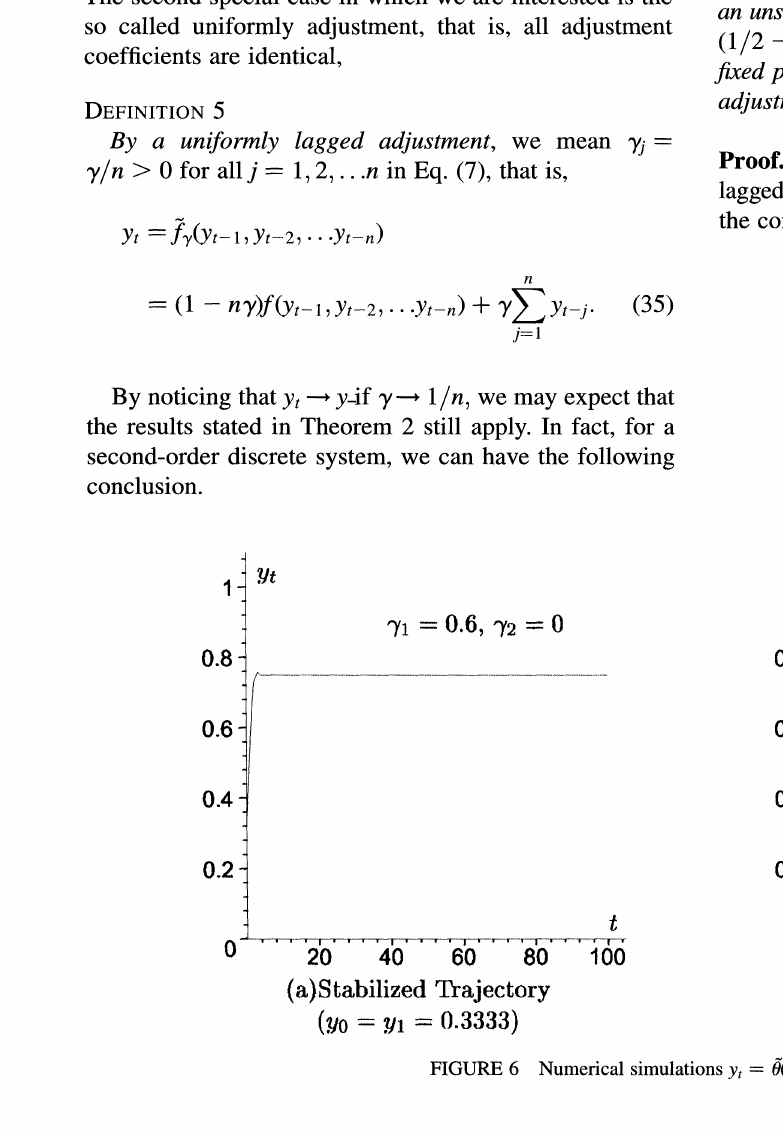
FIGURE 6 Numerical simulations Yt (Yt-I,Yt-2), a